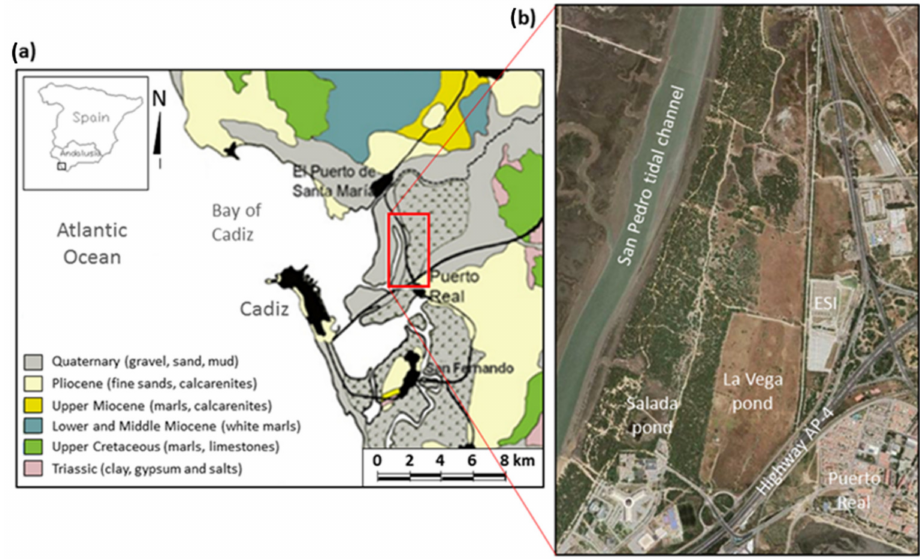
Figure 1. ( a ) Geological map of the study area. ( b ) Aerial photography of the studied